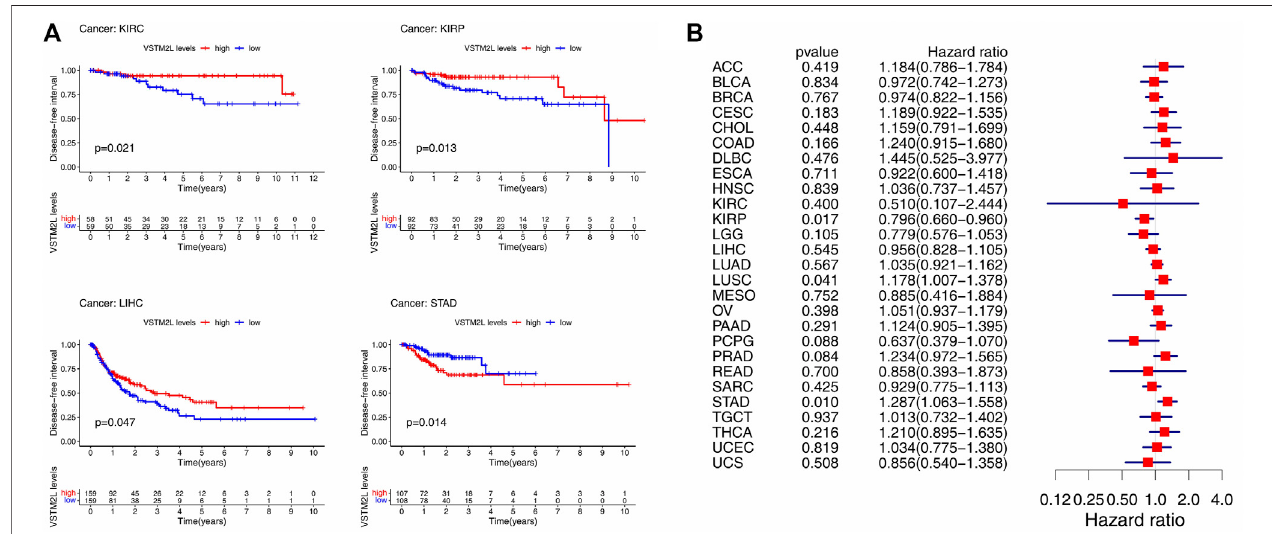
FIGURE 5 | Kaplan – Meier survival and Cox regression analyses of the prognostic value of VSTM2L expression level for DFI in different cancer types. (A) DFI accordingtohighandlow VSTM2L expressioninKIRC, KIRP,LIHC,andSTADfromTCGA. (B) Correlation between VSTM2L mRNAexpression leveland DFIinvarious cancer types. * p < .05.